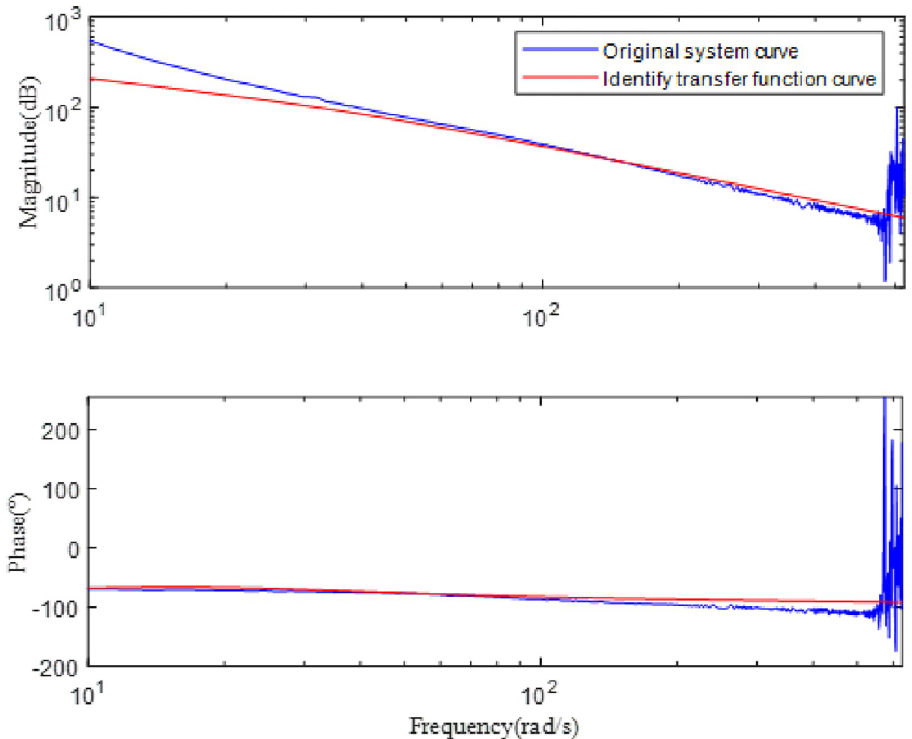
Fig 14. Frequency characteristic curves of acquisition and identification.